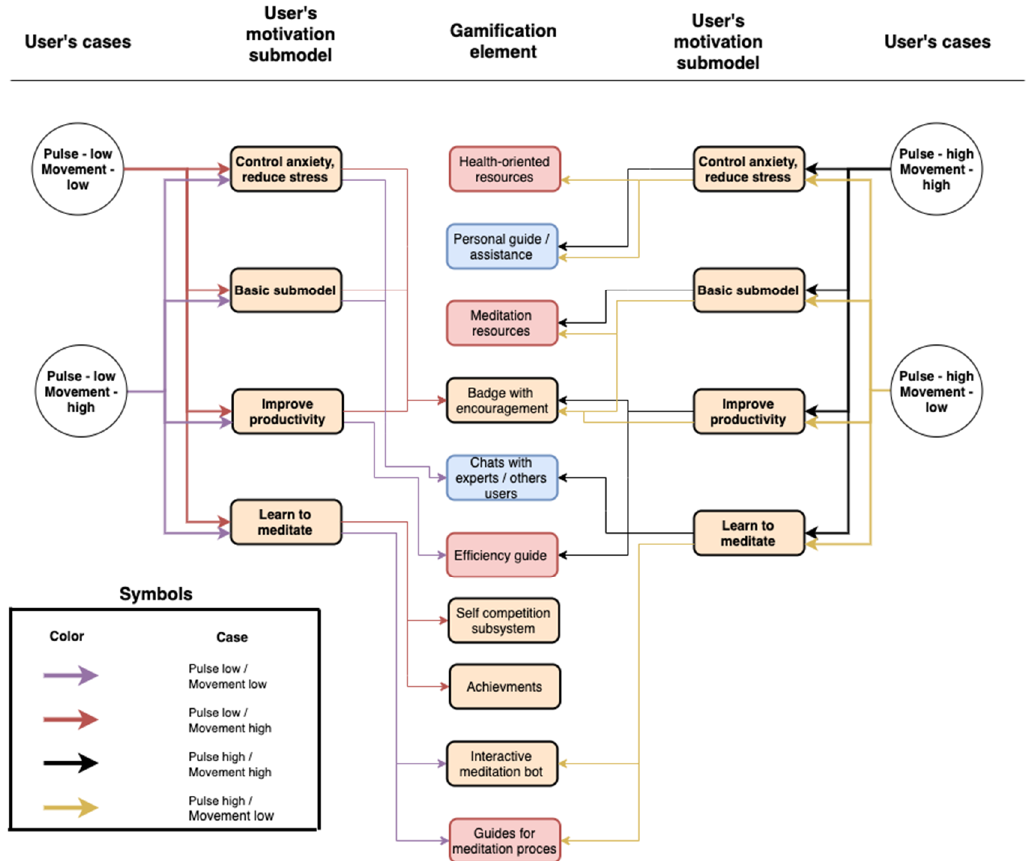
Figure 22. Gamification elements based on a user’s motivational model and the results of their meditation practice.